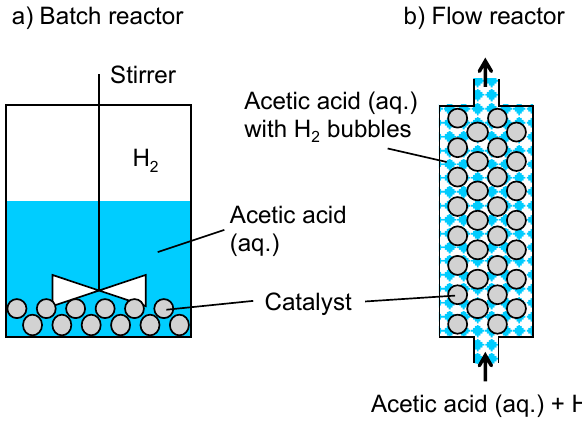
Figure 7. Di ff erence in contact behaviors between H 2 (gas), aqueous acetic acid (liquid), and catalyst (solid) in batch and flow reactors.